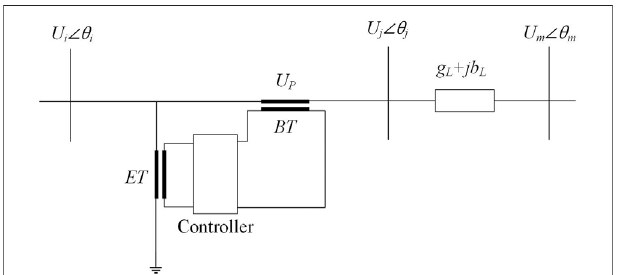
FIGURE 1 | Two-core symmetrical phase-shifting transformer structure diagram.